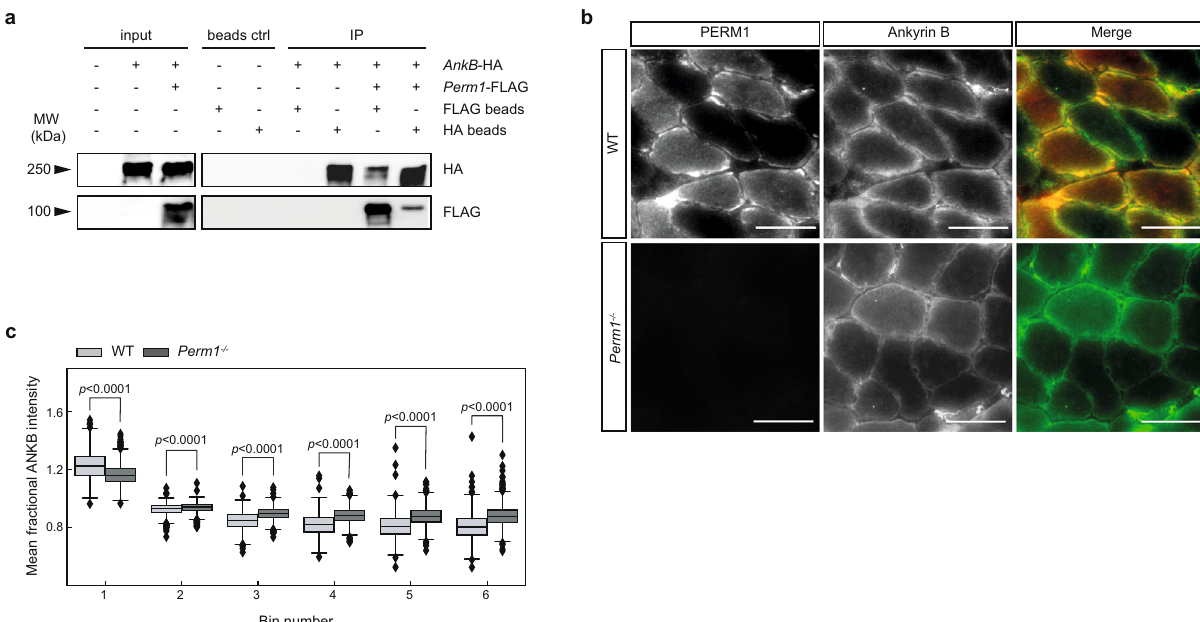
Fig. 6 PERM1 associates with ankyrin B and the interaction with the MICOS – MIB complex is dependent on the transmembrane helix. a PERM1 interacts with ANKB, as indicated by immunoprecipitation of FLAG-tagged Perm1 and HA-tagged ankyrin-B in TREx-293 cells stably expressing Perm1 -FLAG. Protein lysates were immunoprecipitated with anti-FLAG beads and anti-HA beads and immunoblotted with anti-FLAG and anti-HA antibodies. b Immunohistochemical staining of soleus muscle revealed co-localization of PERM1 (red) with ANKB (green). Scale, 50 µ m. c Mean fractional intensity of ANKB signals in bins 1 – 6 from Perm1 − / − and wild-type soleus muscle fi bers. ANKB staining intensity was reduced at subsarcolemmal sites and increased within inter fi brillar mitochondria in Perm1 − / − muscles compared to wild-type controls ( n = 4 mice per group, 2299 quanti fi ed fi bers). Box plot (c) represents the median, 25th, and 75th percentiles, maximum and minimum are connected through whiskers. Outliers are de fi ned as Q 1 – 1.8 IQR and Q 3 + 1.8 IQR. (c) unpaired two-sided Mann-Whitney U -test. Source data are provided as Source Data fi